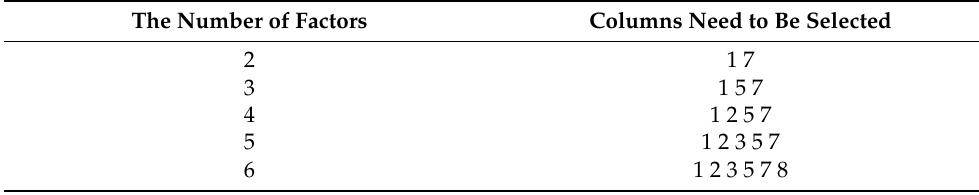
Table 3. A usage table of the U 11 and U 10 uniform layouts. The Number of Factors